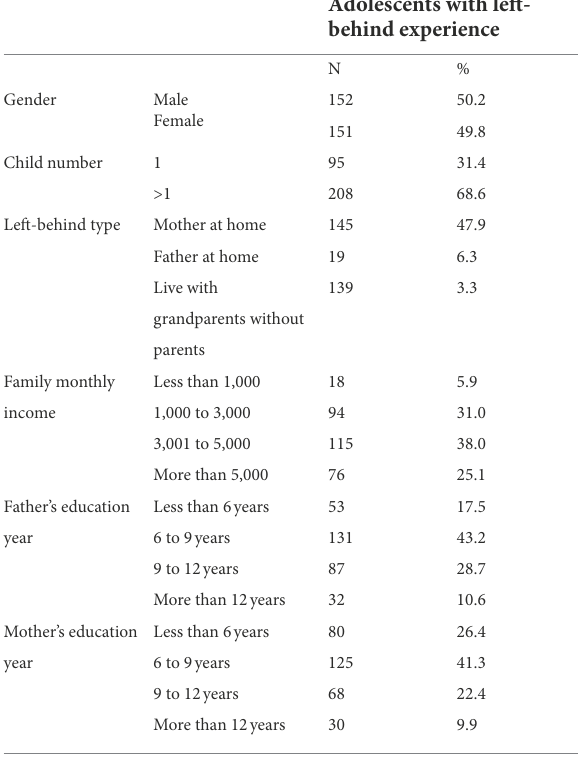
TABLE 1 Demographic information of participants (N = 303).